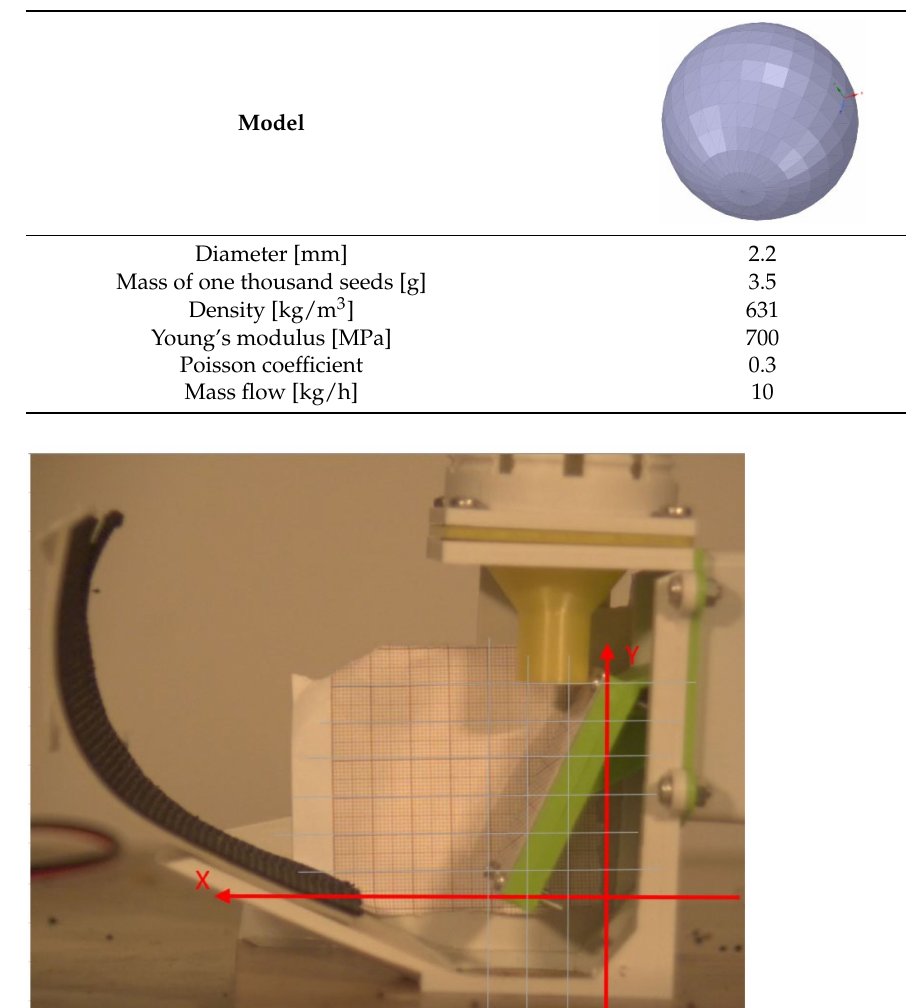
Table 1. Physical properties of rape seeds.